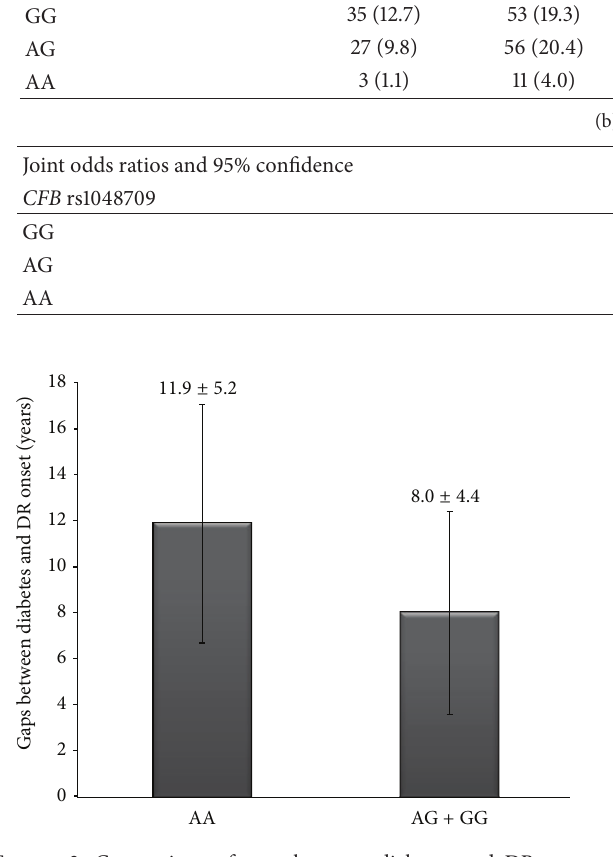
Figure 2: Comparison of gaps between diabetes and DR onset (years) in two genotype groups for CFH rs800292 in DR patients ( 𝑃 < 0.001 ).